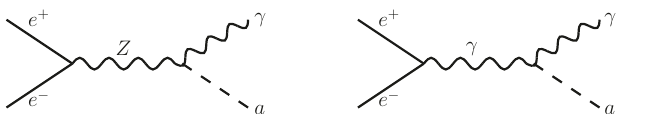
Figure 21 . Feynman diagrams contributing to the process e + e